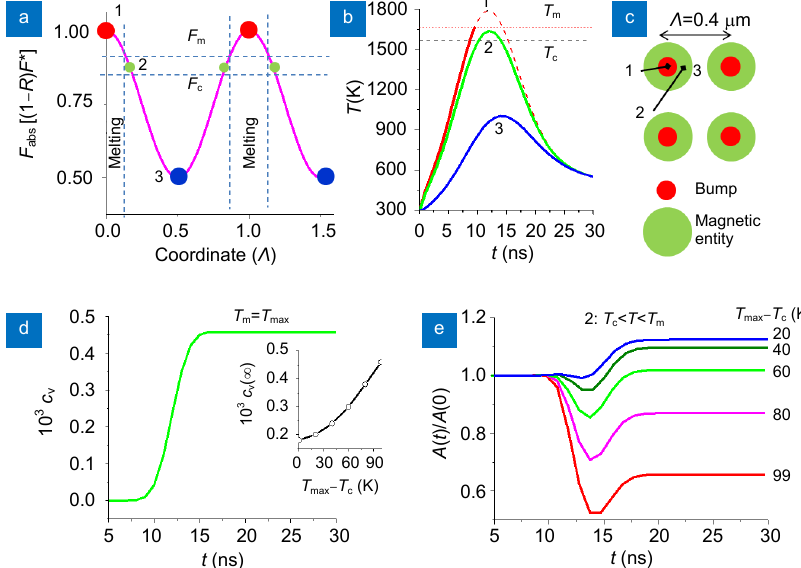
Fig. 5 | ( a ) Absorbed fluence F abs as a function of coordinate along the dashed horizontal line in Fig. 1(b) with indications of different positions: 1. maxima of light intensity, where F abs =(1 – R ) F *> F m ( F m is the absorbed fluence required for raising the temperature up to the melting point T m ); 2. locations outside the melted zones, in which F c < F abs < F m ( F c is the absorbed fluence required for raising the temperature up to T c ); 3. local minima of light intensity. ( b ) T ( t ) dependencies calculated in positions 1, 2, and 3, where the absorbed fluence is respectively F abs =70 mJ/cm 2 , F abs =65 mJ/cm 2 , and F abs =35 mJ/cm 2 . As temperature elevation was calculated with no taking into account effects of melting and resolidification 18,20 , the T ( t ) dependence calculated at F abs > F m is shown by the dashed curve for t > t m , where t m is the moment of time at which the temperature rise reach- es T m . ( c ) Unit cell of the interference pattern with the marks for positions in which the T ( t ) dependences plotted in (b) are simulated. ( d ) Non-equilibrium vacancy concentration c v versus t in zone(s) 2 at T max = T m . The inset shows the asymptotic value c v (  ) at different temperature elevations T max  T c up to T max = T m . ( e ) Concentration wave (superstructure) amplitude A ( t )/ A (0) as a function of time t in zone(s) 2 at different tem- perature elevations T max  T c up to T max = T m